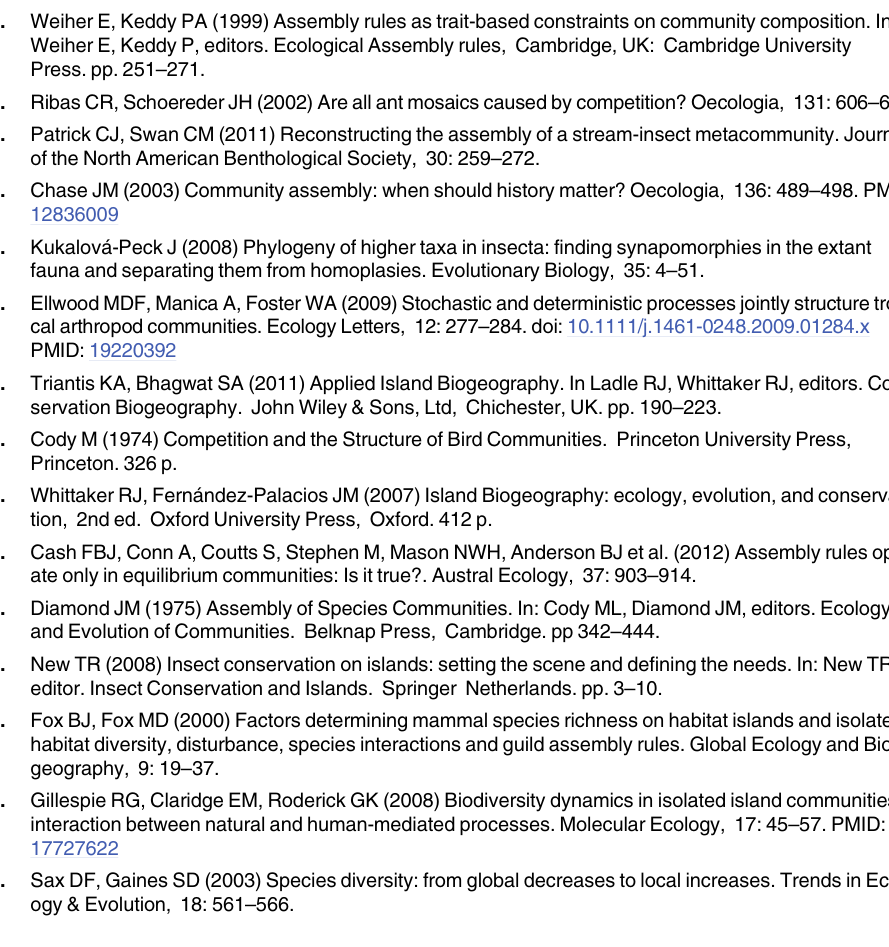
S1 Table. Original data matrices for all analyses of fruit flies species collected in